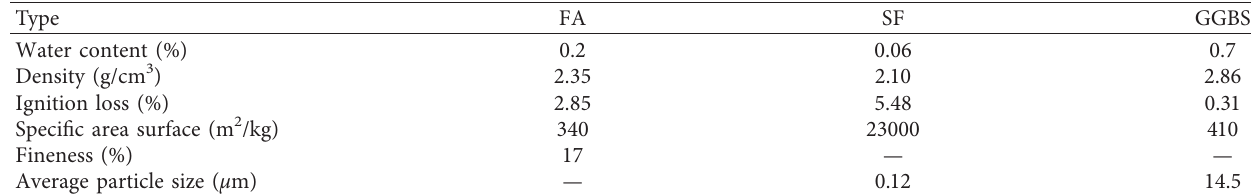
Table 3: Physical properties of admixtures.